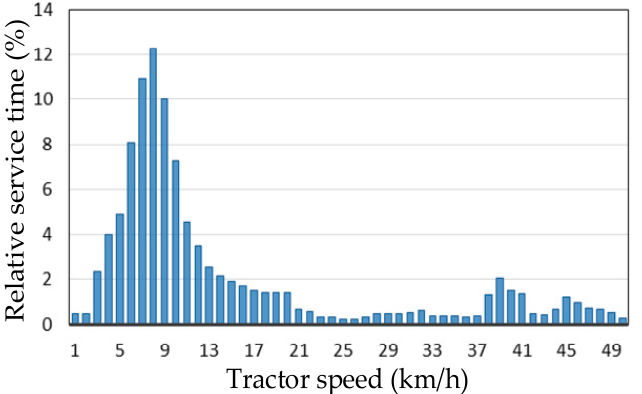
Figure 3. The linear coordinate diagram of the speed usage frequency in the whole life cycle of the agricultural tractor.